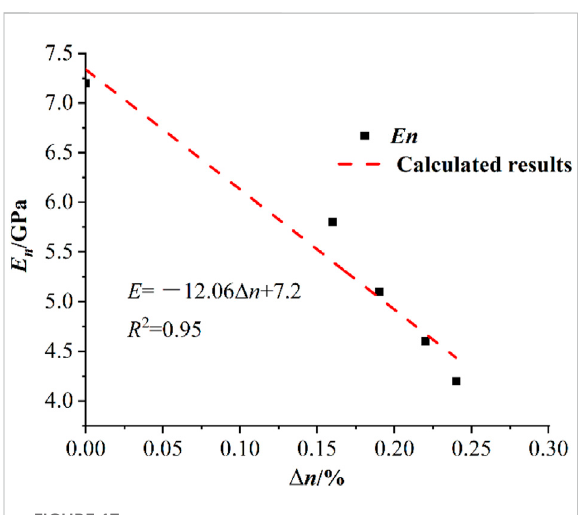
FIGURE 17 Relationship between the elastic modulus and porosity change of the granite